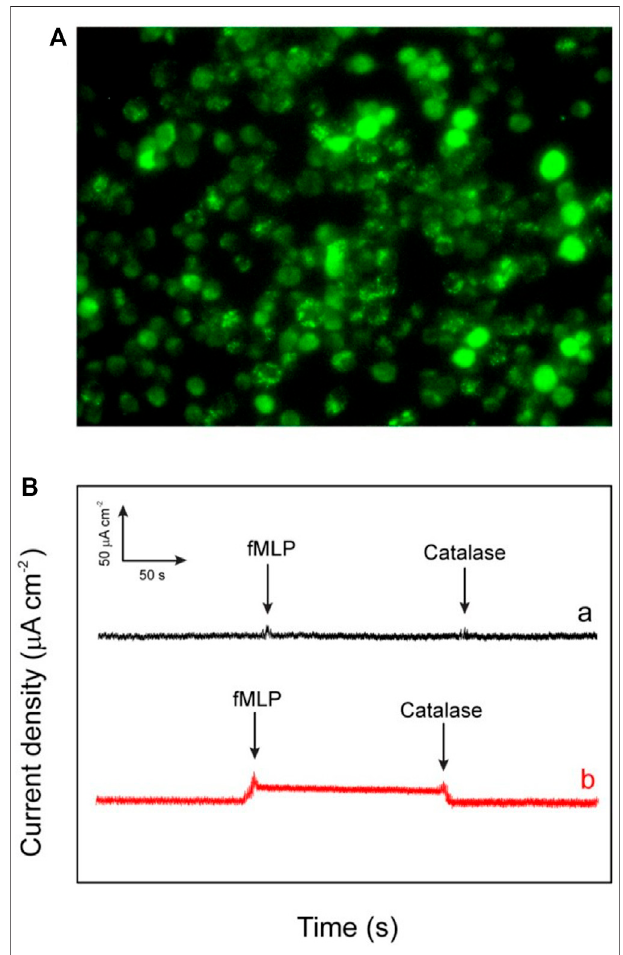
FIGURE 8 | (A) The dark fi eld image of the macrophages (RAW264.7 murine)investigatedforthe invitro applications (B) Amperometricresponseof HRP/Au NPs-PDA-PAA-graphene electrode for measuring the reducibility of H 2 O 2 released macrophage cells induced upon the addition of 0.3 mm fMLP (A) and without addition of 50 ml of catalase (300 UmL − 1 ) (B) . The electrode was checked at bias value of a consistent potential of − 320 mV (versus